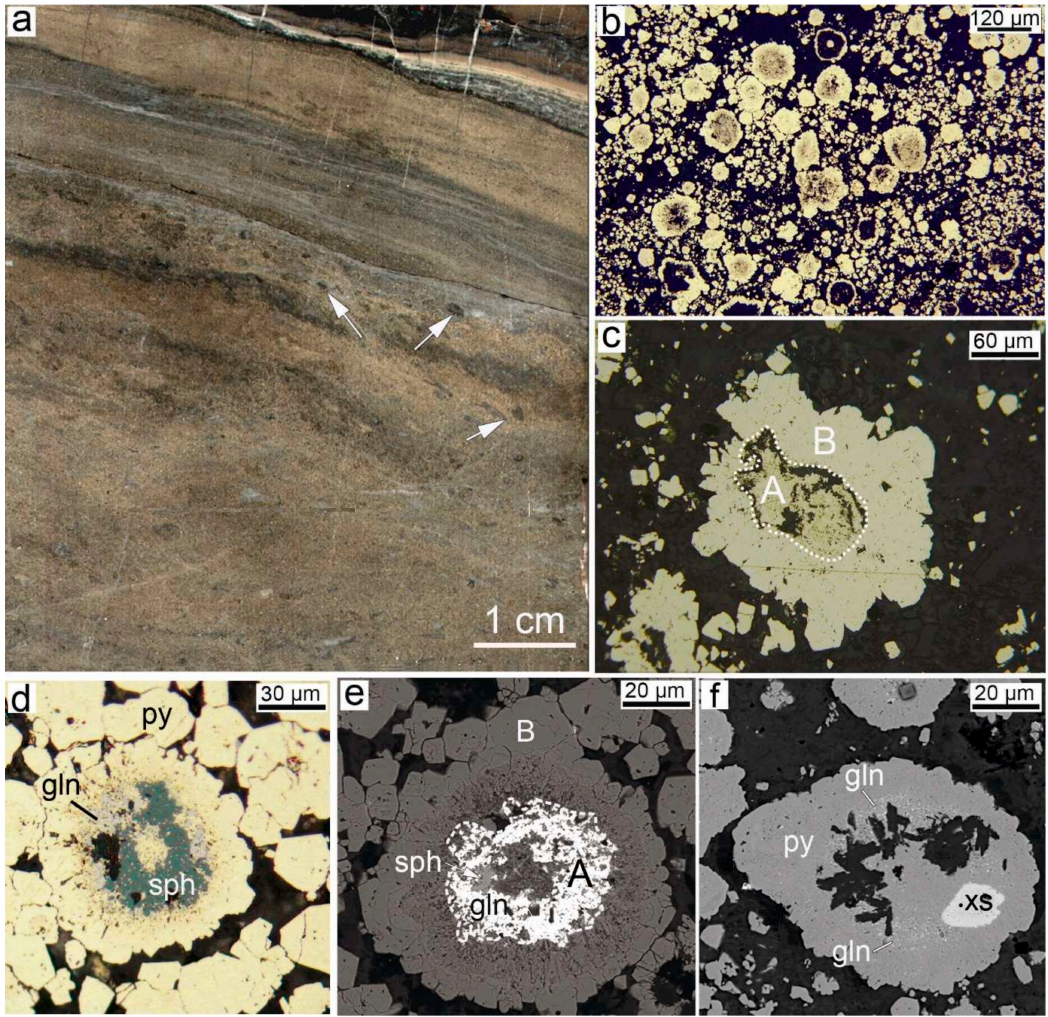
Figure 4. Pyrite nodules in sulfide–carbonate–hyaloclastite diagenites of the Talgan deposit: ( a ) sulfide–carbonate–hyaloclastite diagenite with thick sulfide layers, thin carbonate–hyaloclastite interlayers (gray and black), and chloritized hyaloclasts (indicated by arrows), polished sample; ( b ) pyrite nodules and crystals in sulfide layers; ( c ) zoned pyrite nodule in carbonate–hyaloclastite matrix; ( d , e ) replacement of fine-grained pyrite (py) from the core by sphalerite (sph) and galena (gln); ( f ) galena and xenotime (xs) inclusions in pyrite nodules. Reflected light ( b – d ); SEM-photo ( e , f